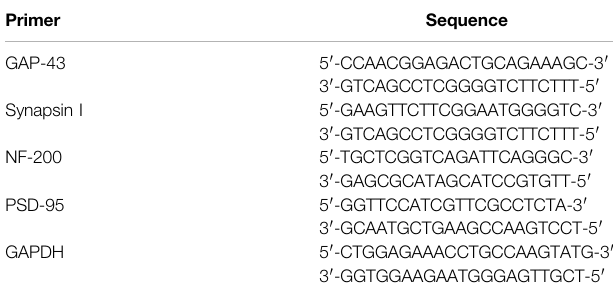
TABLE 1 | Speci fi c primers used for real-time PCR